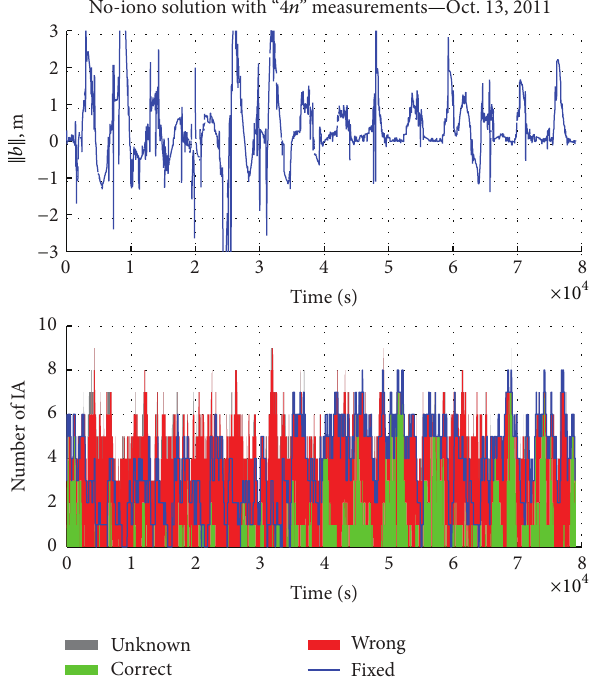
Figure 3: Baseline magnitude estimation error and L1 ambiguities estimation performance for set 4𝑛